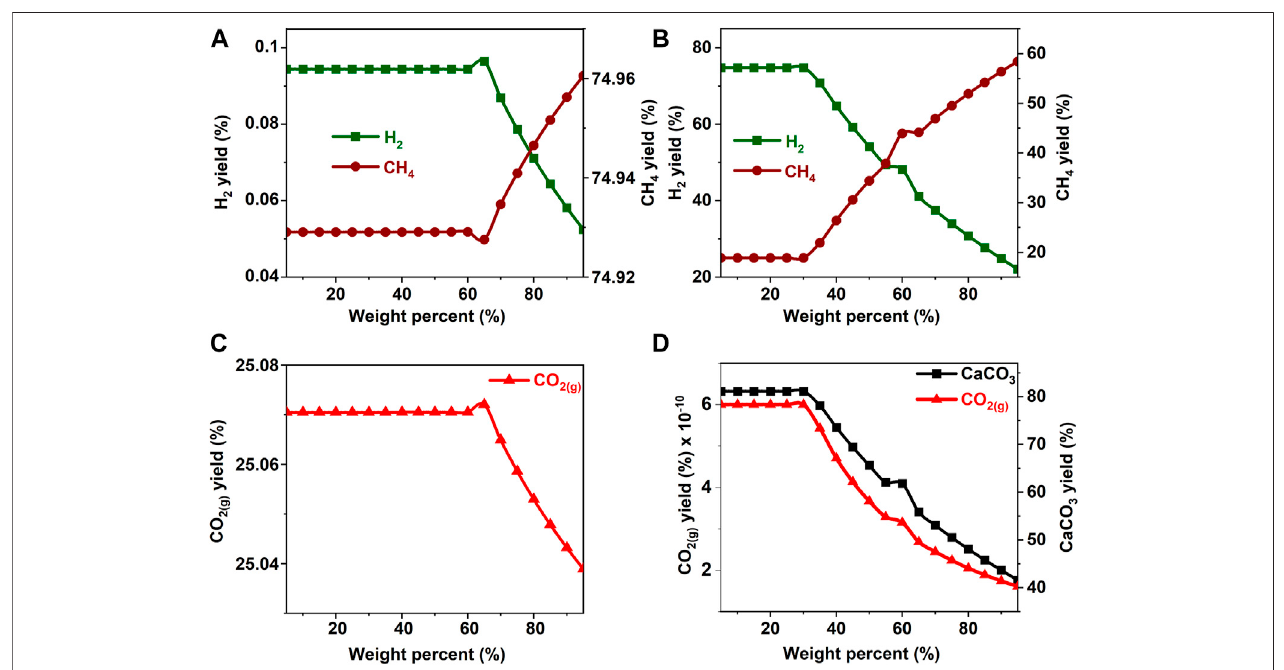
FIGURE 3 | Effect of methanol concentration on the product yield (A , C) in the absence and (B) in the presence of calcium oxide. The yield of CO 2 post capture to produce calcium carbonate is represented in 1 (D) . These calculations are performed with temperatures of 227 ° C and pressures of 50 bar.